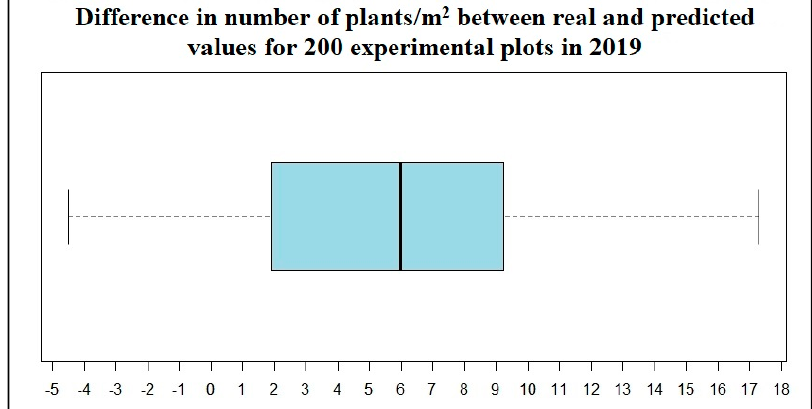
Figure 4. Box plot of difference in the number of plants/m 2 between the real and predicted values for 200 experimental plots in 2019.